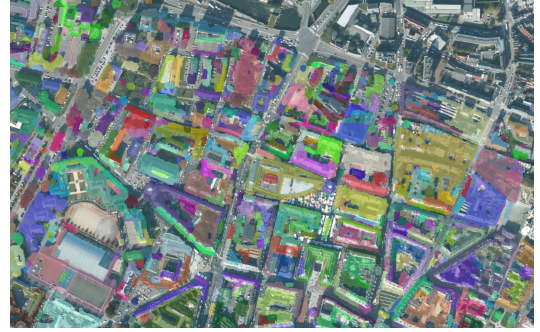
Figure 1: Results on the focusing step : one color per